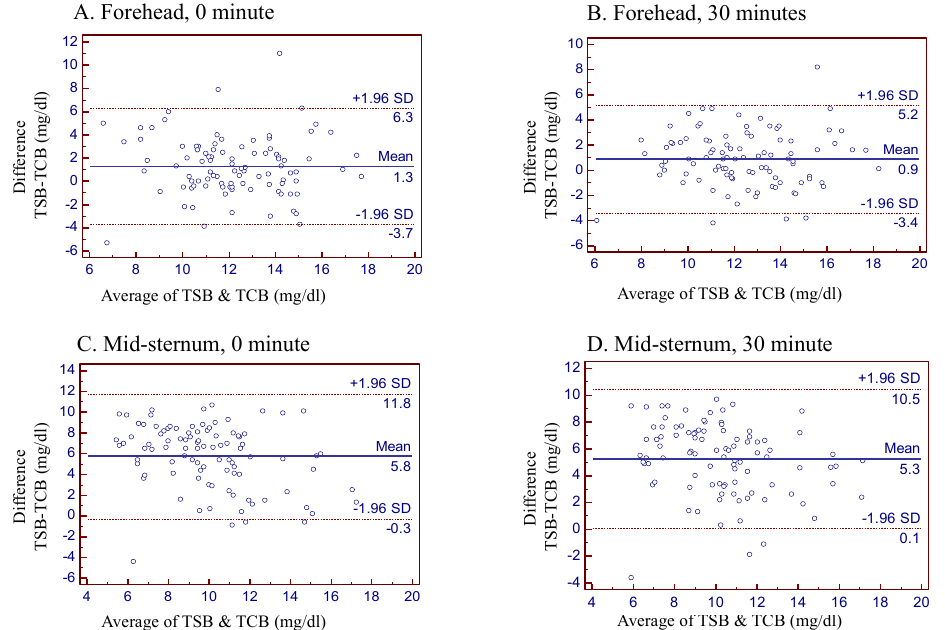
Figure 1. Bland–Altman plot for evaluation agreement between TCB and TSB measurements in neonates after phototherapy. ( A ) Forehead (0 min), ( B ) Forehead (30 min), ( C ) Mid-sternum (0 min) and ( D ) Mid-sternum (30 min).